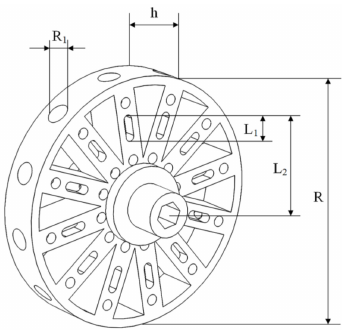
Figure 2. The schematic diagram of the seeding wheel